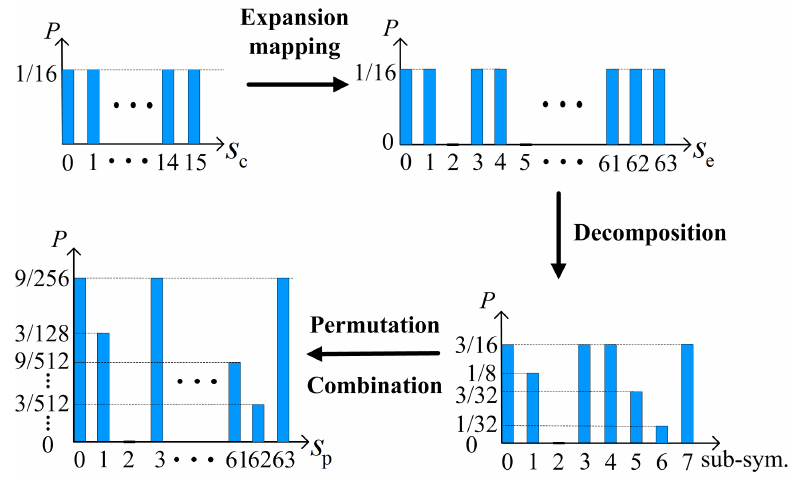
Figure 4. The probability distribution of the nonequiprobable